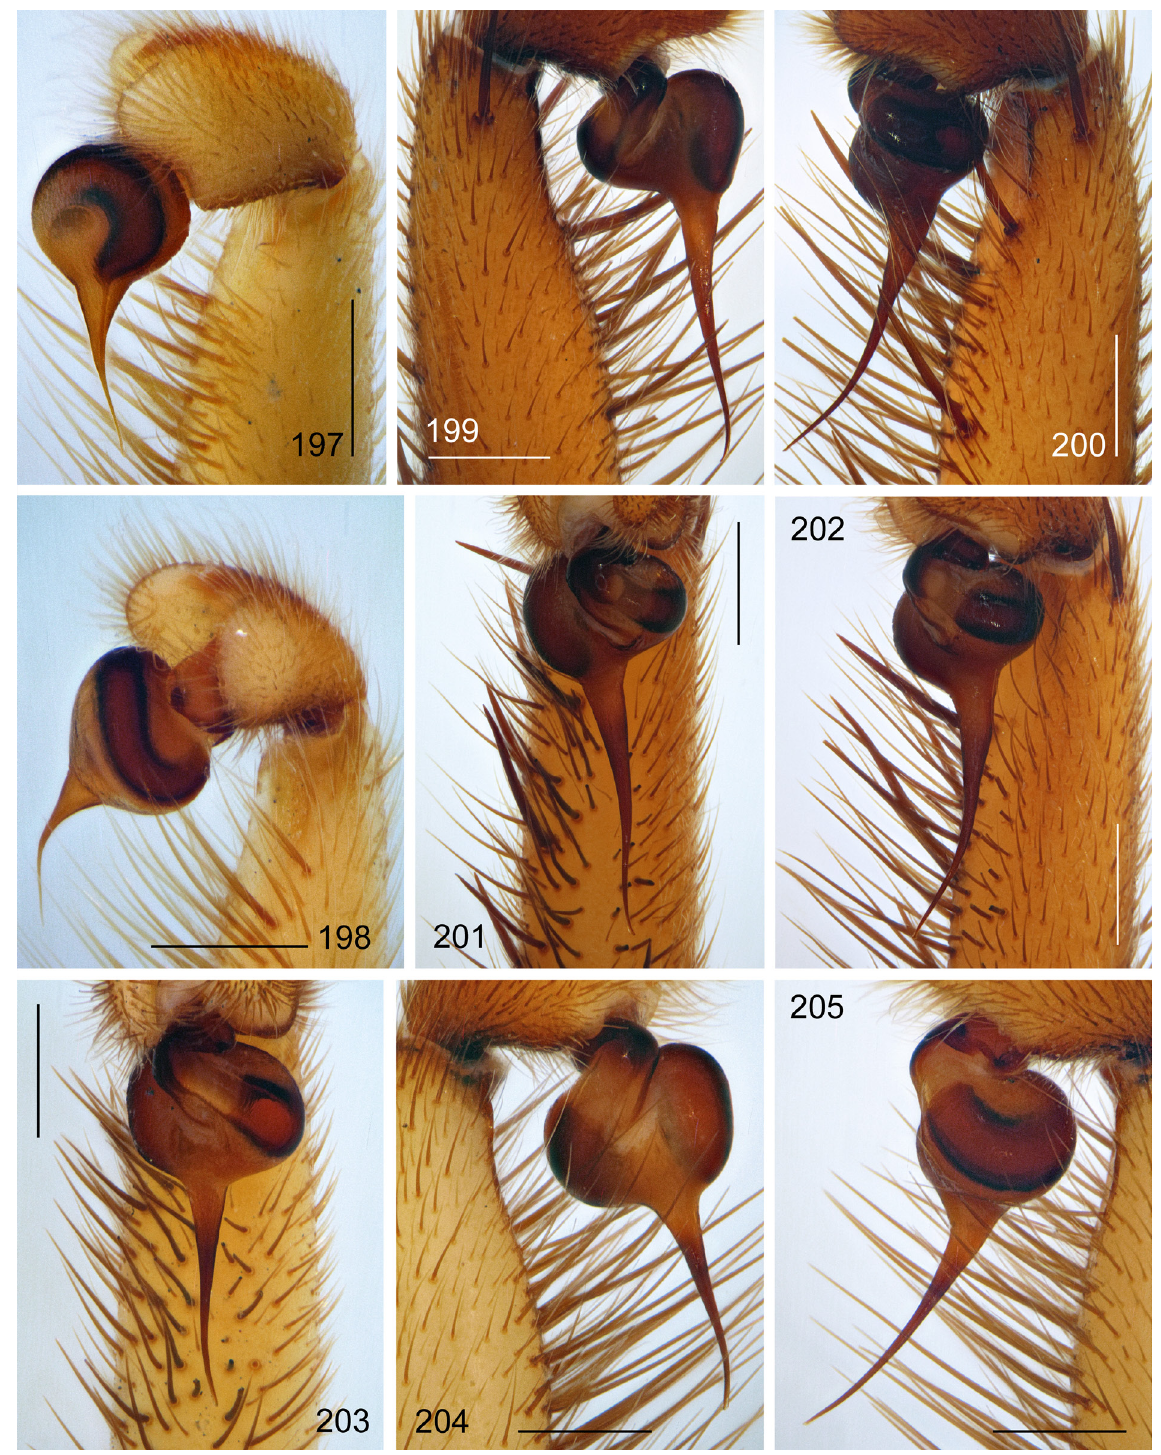
Figs 197–205. Anemesia spp., ♂♂, details of palpal organ; proventral (197), retroventral (198, 202), ventral (199, 201, 203–204) and retrolateral (200, 205) views. 197–198 . A. andreevae sp. nov. (holotype). 199–202 . A. oxiana sp. nov. (holotype and paratype from Sanglok Mts, respectively). 203– 205 . A. sogdiana sp. nov. (conspecific ♂ from Zaamin and holotype, respectively). Scale bars: 0.5